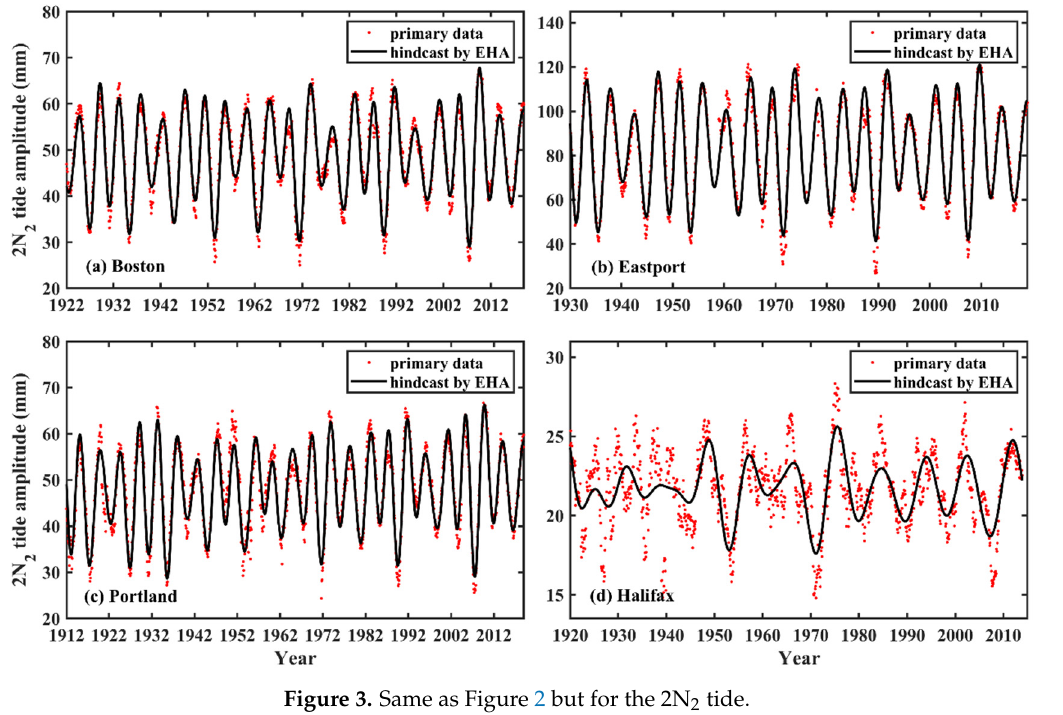
Figure 2. The primary amplitudes (red dots) and the hindcasts amplitudes by the EHA method (black lines) of N 2 tide at 4 stations with the best-fit numbers of IPs for the 8.85-year cycle (listed in Table 6).